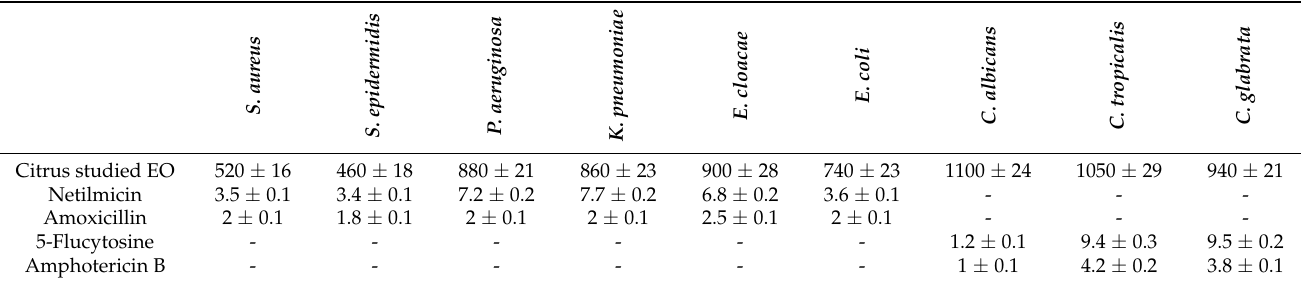
Table 2. Antimicrobial activity of the EO (MIC µ g/mL).